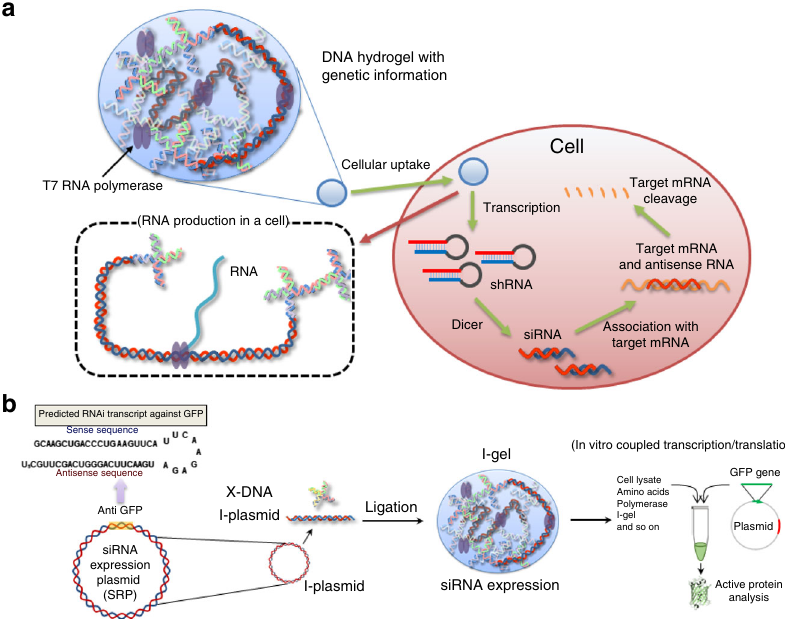
Fig. 1 Illustration of RNAi mechanism of I-gel. a A schematic diagram illustrating the I-gel mechanism in a living cell. b A schematic diagram illustrating the I-gel mechanism in a cell lysate